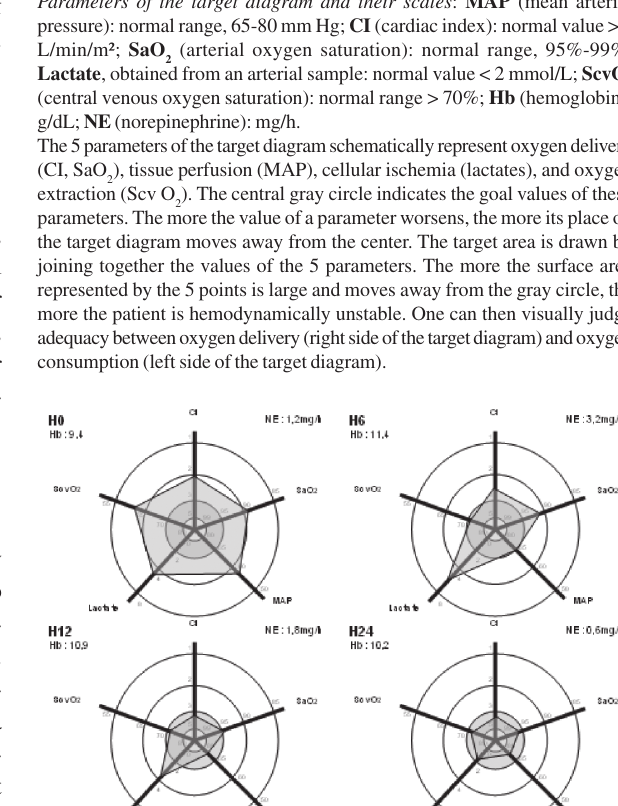
Figure 1 - The hemodynamic target diagram Parameters of the target diagram and their scales : MAP (mean arterial